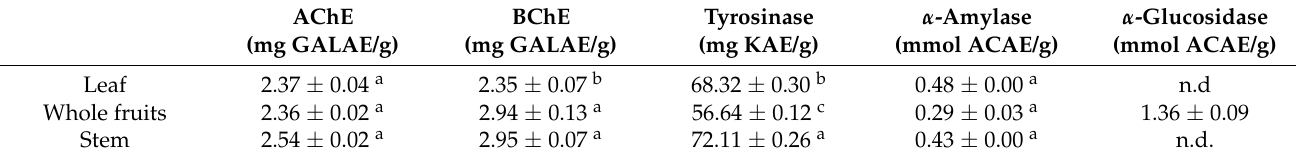
Table 3. Enzyme inhibitory activities of different Cydonia oblonga mill. extracts